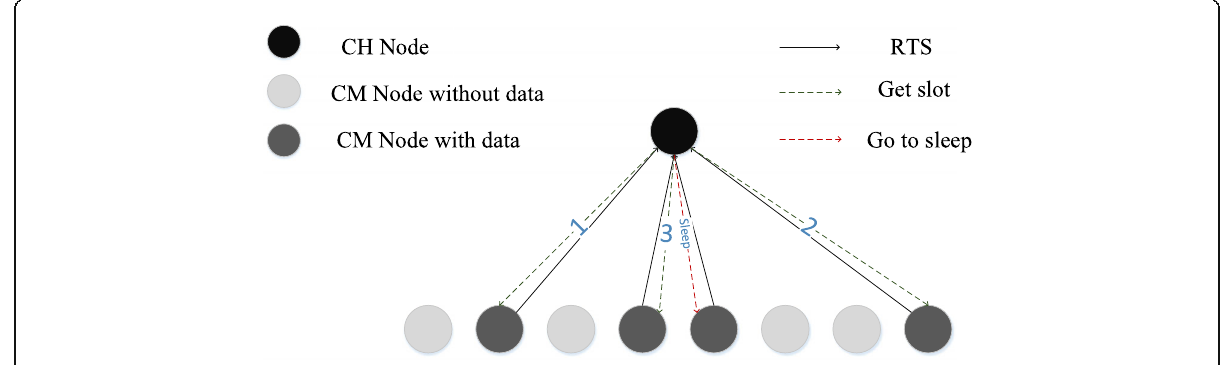
Fig. 3 Schematic diagram of the workflow of the CH